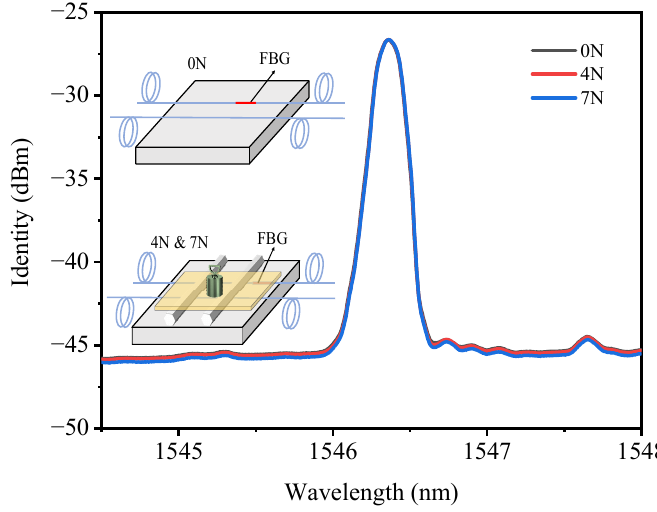
Figure 6. Reflective spectrum of fiber under different stresses.